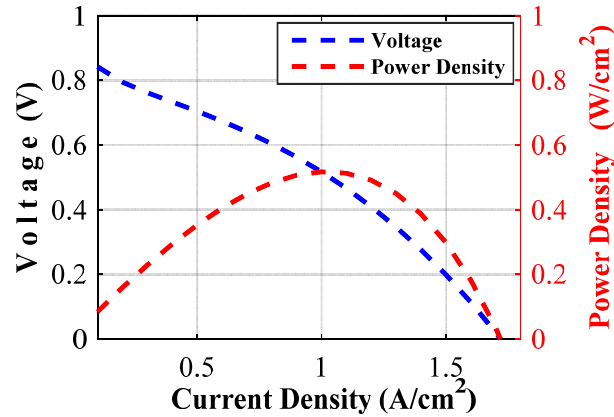
Figure 5. FC terminal voltage as a function of total pressure at the cathode.